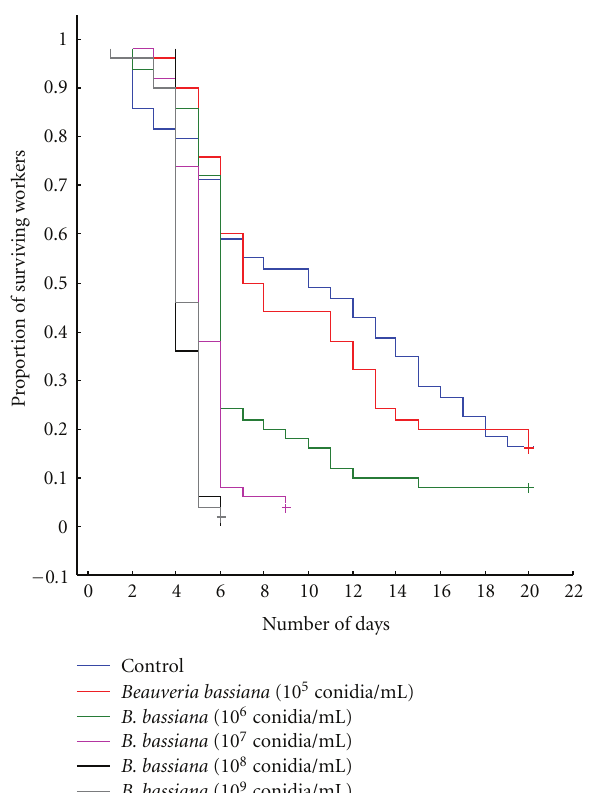
Figure 3: Cumulative time-related survival proportion (Kaplan- Meier curves) of the Atta bisphaerica worker ants after being treated with di ff erent suspension concentrations of the Beauveria bassiana fungus